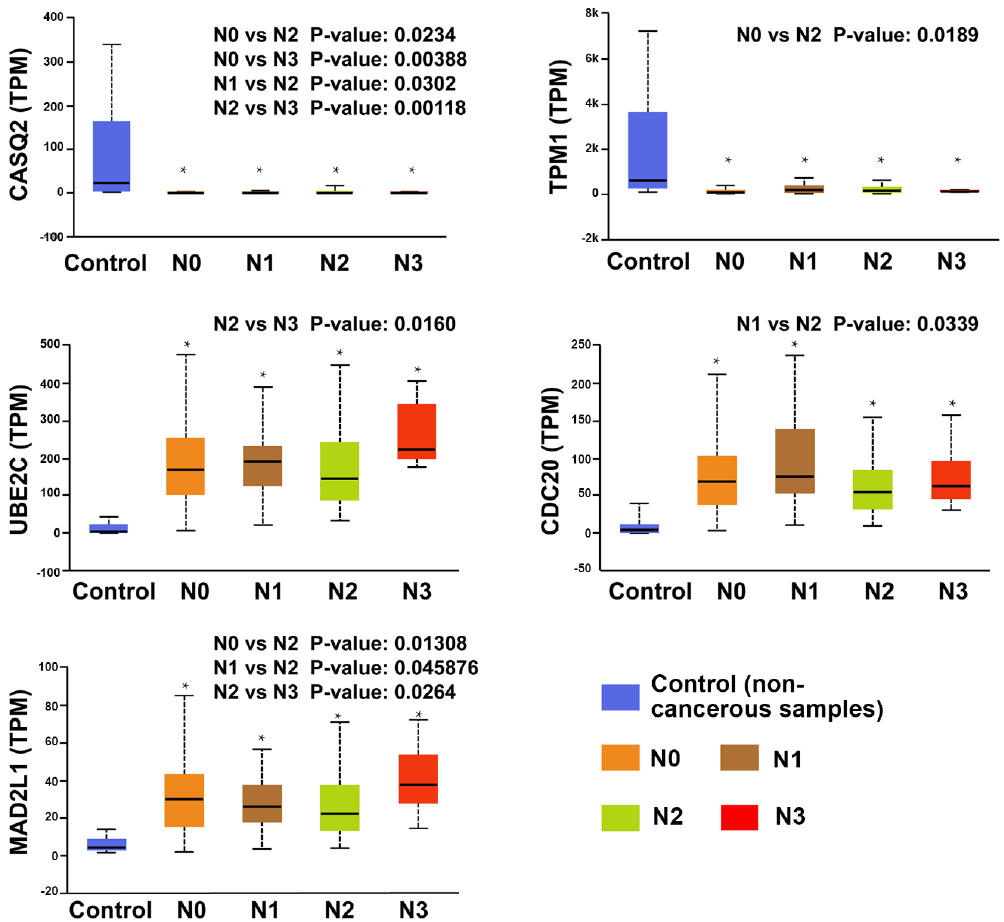
Figure 6. Box plots of gene expression levels of significantly altered hub genes in noncancerous bladder samples and BCa samples with different lymph nodal metastasis status. Controls = noncancerous samples from TCGA-BLCA ( n = 19); Subgroups of BCa: N0 = no regional lymph node metastasis ( n = 237 cases), N1 = metastases in 1–3 axillary lymph nodes ( n = 46 cases), N2 = metastases in 4–9 axillary lymph nodes ( n = 75 cases), and N3 = metastases in 10 or more axillary lymph nodes (eight cases) [23]. TPM = transcripts per million; * = significant difference compared with noncancerous tissues ( p < 0.01).